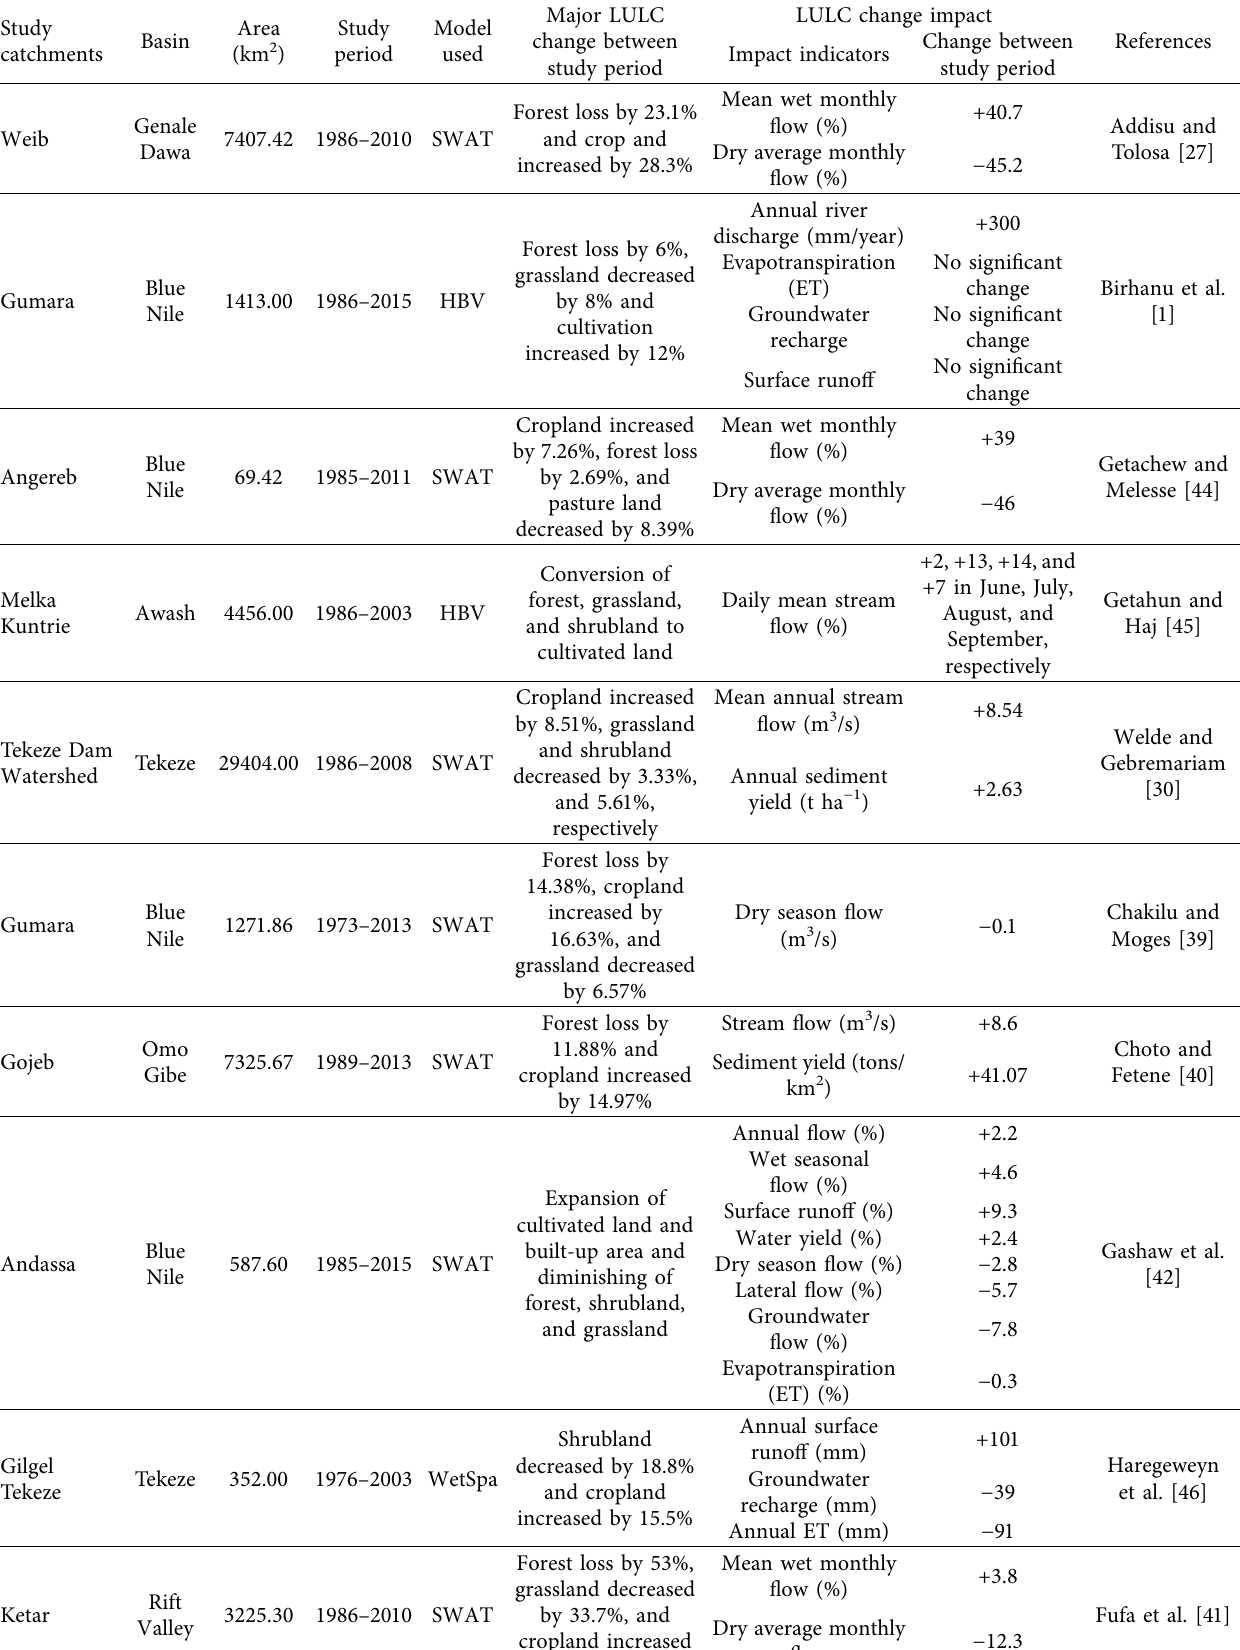
Table 2: Previous studies on LULC change impact on hydrological responses in